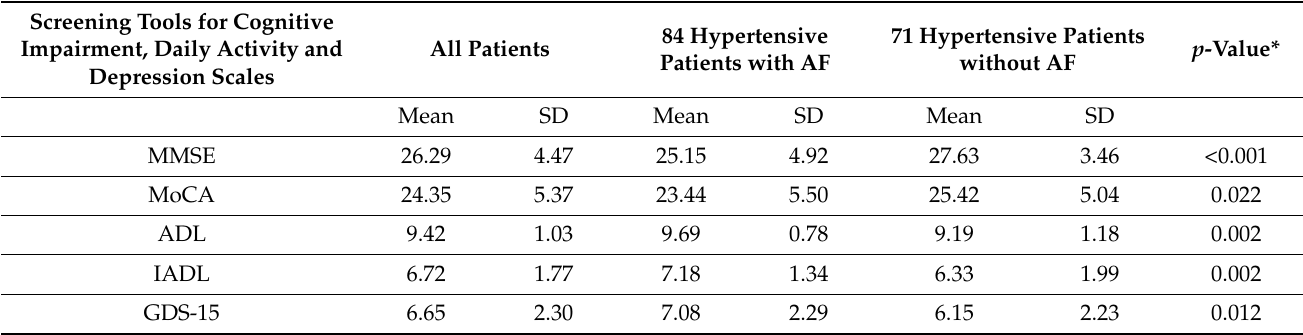
Table 5. Screening tools for cognitive impairment, daily activity, and depression scalesin both groups of patients. Screening Tools for Cognitive 84 Hypertensive 71 Hypertensive Patients p -Value* Impairment, Daily Activity and All Patients Patients with AF without AF Depression Scales Mean SD Mean SD Mean SD MMSE 26.29 MoCA